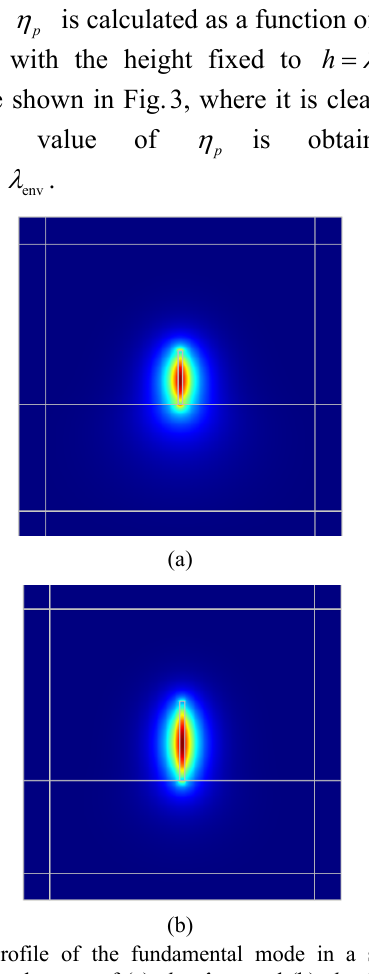
3 2  h . In  h and (b) env env 0.175 w  . env